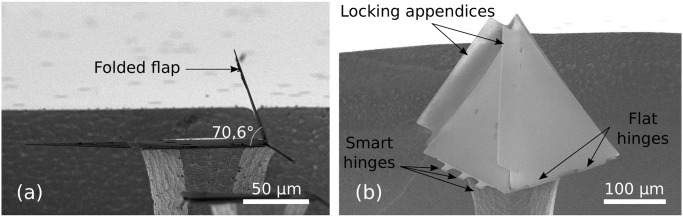
Folded structure arrested by 70.6° stop-programmable hinges.(a): Side view of an extruded-2D structure. The flap is 100 μm wide and the complex hinge has an original width of 40 μm. The flap of the left hand side, connected with a flat hinge, reopened after folding because of an insufficient bonding area. (b): Folded tetrahedron. The faces have sides of 200 μm, the complex hinges are 20 μm wide and the flat hinges are 10 μm wide.